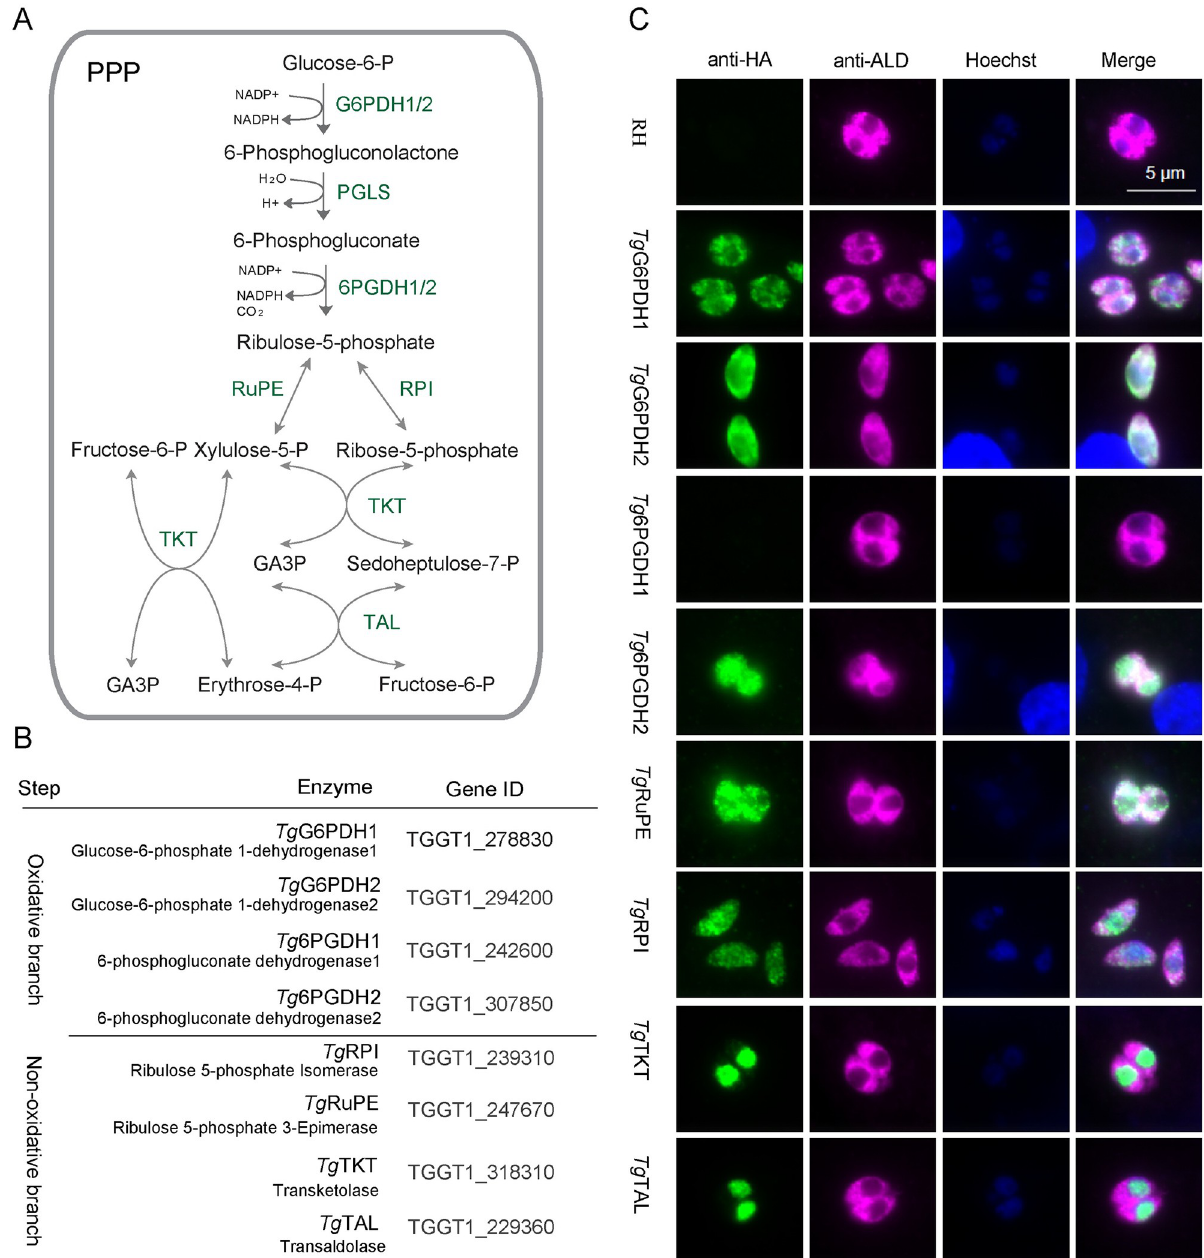
Fig 1. Toxoplasma gondii encodes its pentose phosphate pathway within 2 subcellular locations. (A) , Schematic representation of the pentose phosphate pathway in Toxoplasma parasites. (B) , Gene ID of the PPP genes. (C) , Representative images of immunofluorescence assay. Different enzymes of PPP tagged at the C terminus with smHA epitope by CRISPR-Cas9-mediated homologous recombination in the RH Δ ku80 strain. Subsequently, the parasites of testing strains were fixed, permeabilized and stained with mouse anti-HA and rabbit anti- Tg ALD, which were detected by Alexa 488- and Alexa 594-conjugated secondary antibodies, respectively. Tg ALD and Hoechst were used as the cytoplasm and cell nucleus markers, respectively. Bar = 5 μ m.